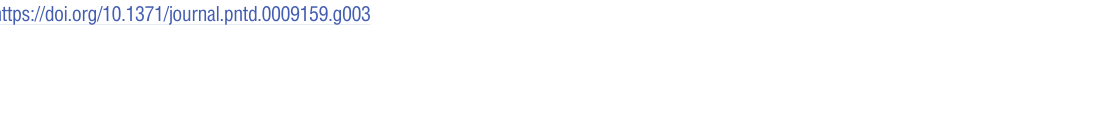
PLOS NeglectedTropical Diseases | https://doi.org/10.1371/journal.pntd.0009159 February 19,